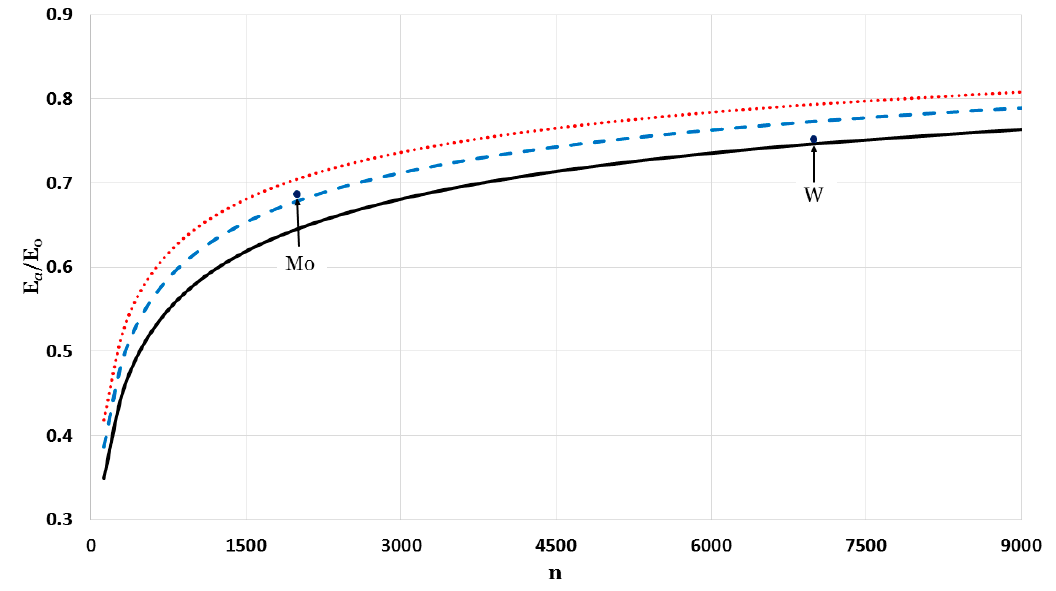
Figure 7. The variation of the relative cohesive energy of nanoparticles in a face-centered cubic structure as function of the number of atoms for m = 2 and di ff erent values of α : 2.3 (black solid line), 2.4 (blue dashed line), and 2.4 (red dotted line). The experimental values [23,24] are denoted by dark blue circles.